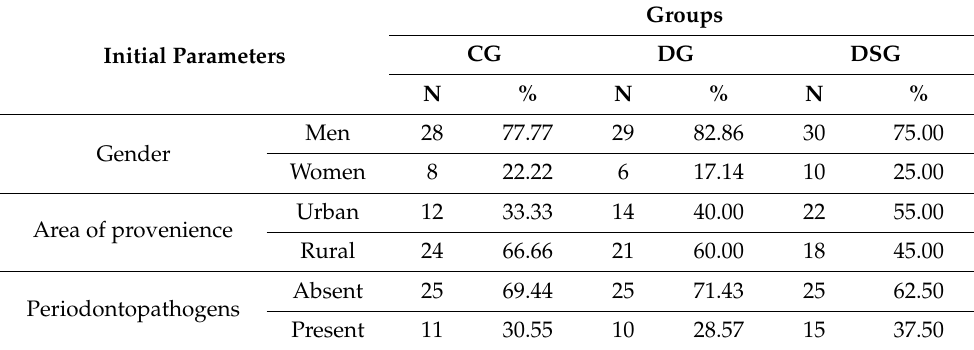
Table 1. Initial parameters about gender, source environment, and